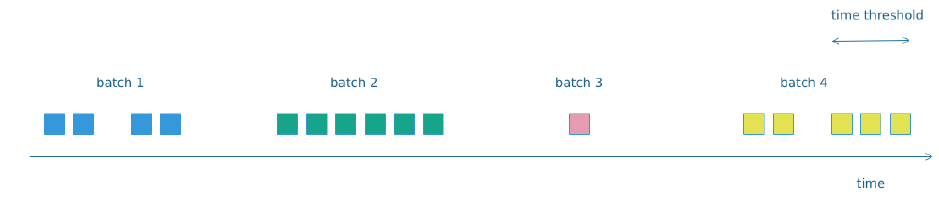
Figure 6. Building packet batches for Non-IP